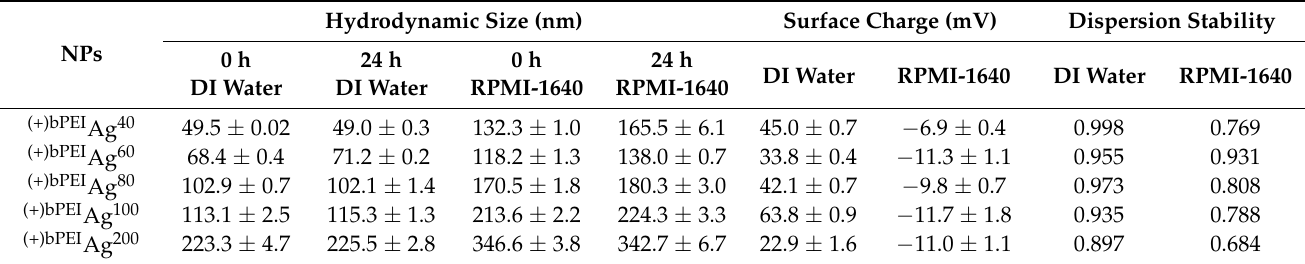
Table 1. Physicochemical properties of Ag NPs used in this study. Dispersion stability is the ratio of UV–vis absorbance values measured at 0 and 24 h. The standard deviations of 3 replicate measurements are given as confidence intervals. Hydrodynamic Size (nm) Surface Charge (mV) Dispersion NPs